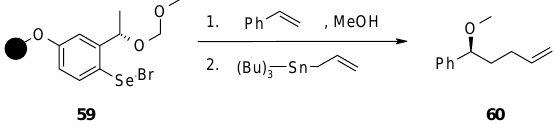
Figure 16. Tris(trimethylsilyl)germane.